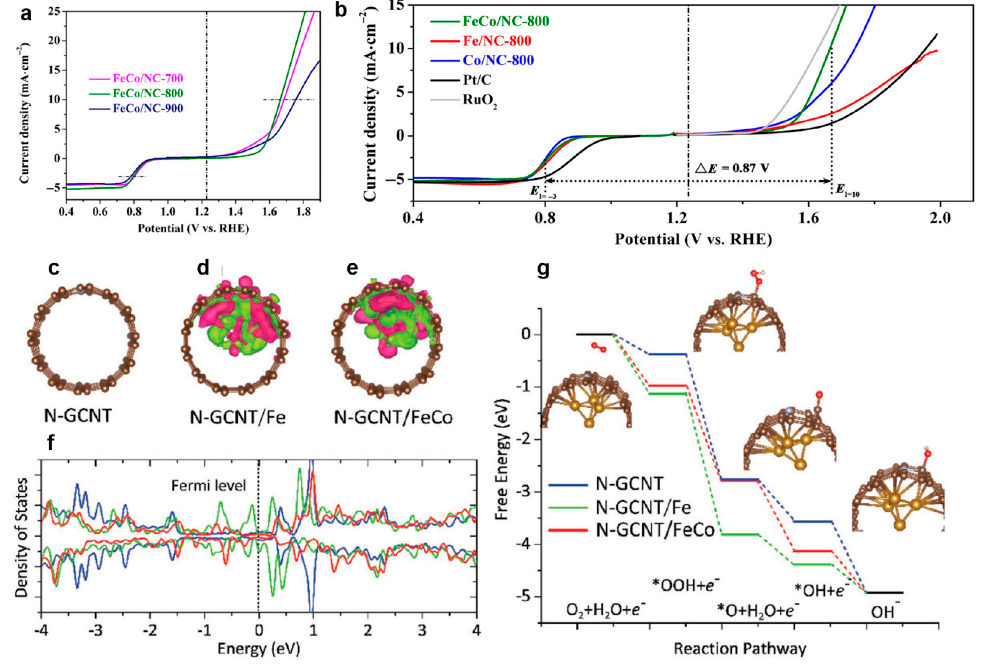
Figure 11. ( a ) OER and ORR activities of FeCo / NC-700, FeCo / NC-800, and FeCo / NC-900 in 0.1 M KOH solution from 0.4 to 1.9 V; ( b ) LSV curves of Fe / NC-800, Co / NC-800, FeCo / NC-800, Pt / C, and RuO 2 samples from 0.4 to 2.0 V, reproduced with permission from [27]. Copyright Springer Nature, 2017. ( c ) The optimized morphology of bare N-GCNT. ( d ) The isosurface (0.1e Å − 3 ) of charge density variation in N-GCNT / Fe. Green area represents decrease in charge density ( ∆ ρ < 0) and purple area represents increase in charge density ( ∆ ρ > 0). ( e ) The isosurface of charge density variation in N-GCNT / FeCo. ( f ) The simulated density of states for the p orbitals of the active C atoms in N-GCNT, N-GCNT / Fe, and N-GCNT / FeCo. ( g ) The free-energy plot of the *OOH, *O, *OH intermediates in the typical 4e − reaction-pathway for ORR catalyzed by N-GCNT, N-GCNT / Fe, and N-GCNT / FeCo, reproduced with permission from [42]. Copyright Wiley,